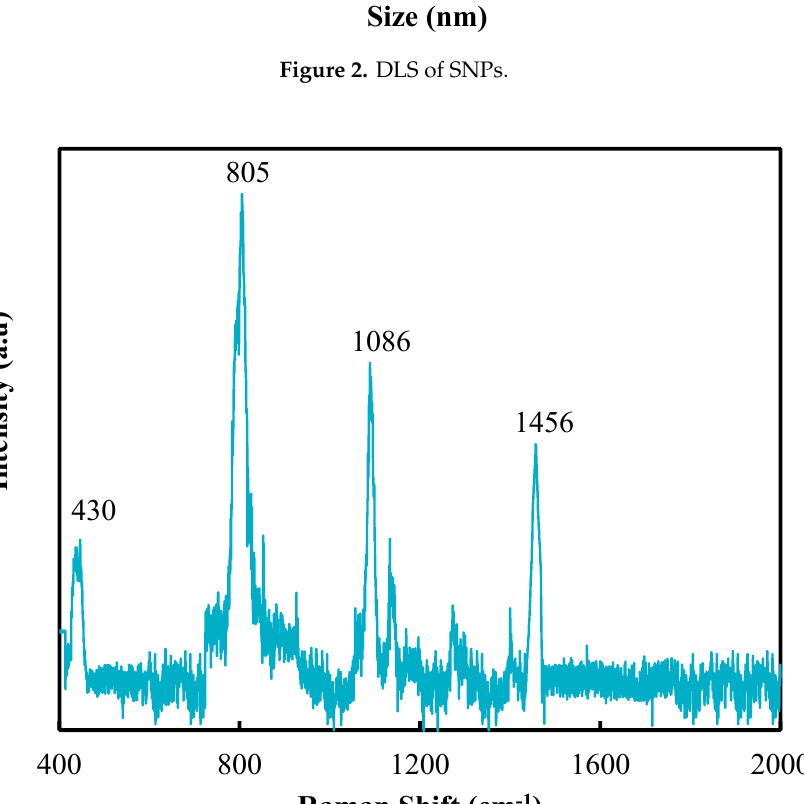
Figure 3. Raman spectrum of SNPs.